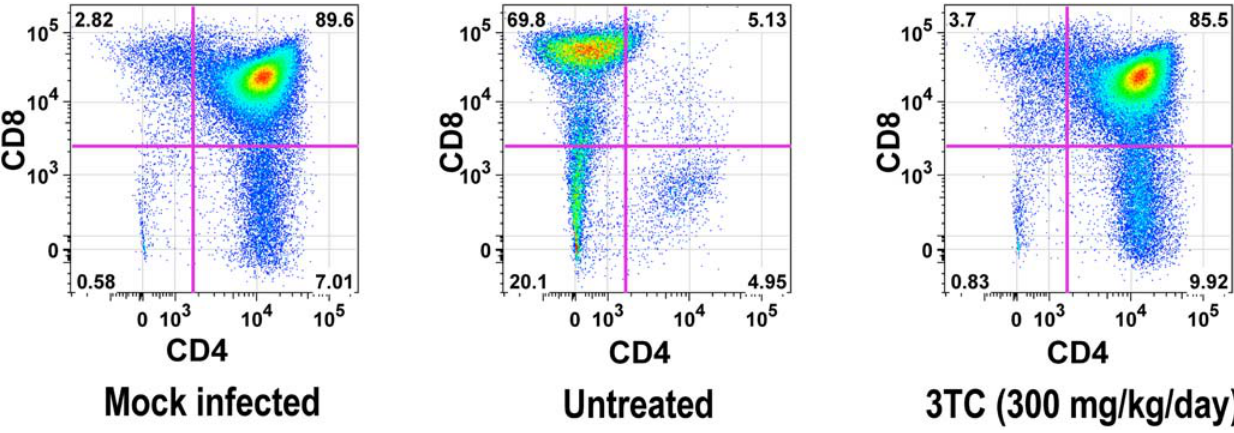
Figure 3. 3TC treatment protects HIV-1 JD-infected Thy/Liv implants from thymocyte depletion. Flow cytometric analysis of representative implants stained for CD4 and CD8 obtained 28 days after inoculation with HIV-1 JD shows severe depletion of DP and CD4 + thymocytes in an untreated mouse and nearly complete protection from thymocyte depletion by 3TC treatment (300 mg/kg per day beginning on day + 1 after inoculation).